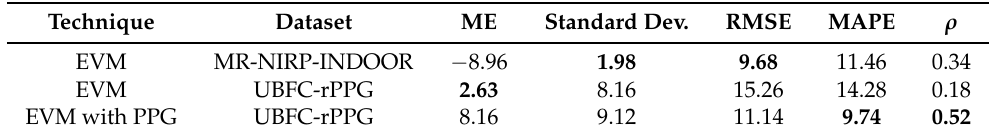
Figure 6. Feature image generated from the reproduction of the article [26]. Table 3. Comparison of EVM network